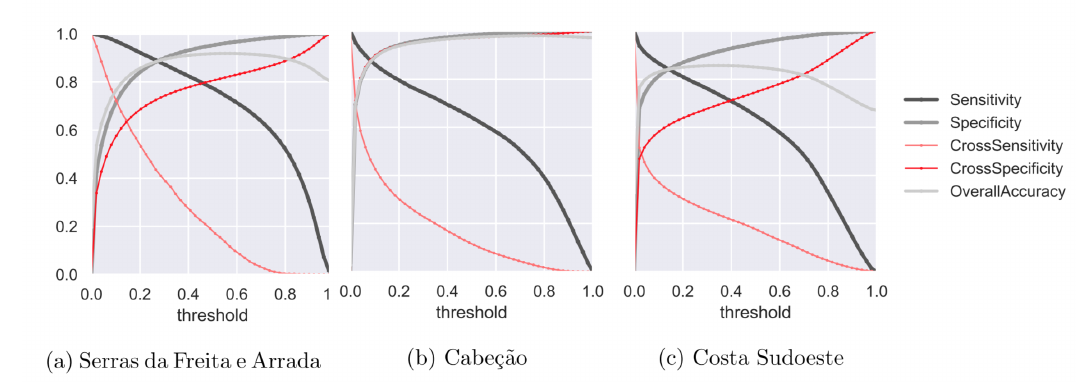
Figure 5. Model performance for the validation regions in three different study locations. The continuous output of the model was thresholded at 50 values between 0 and 1. For each threshold (abscissa) the sensitivity and specificity (ordinate) was calculated. Both cross-sensitivity and cross-specificity were calculated using ground truth maps for coniferous forests in the respective regions.